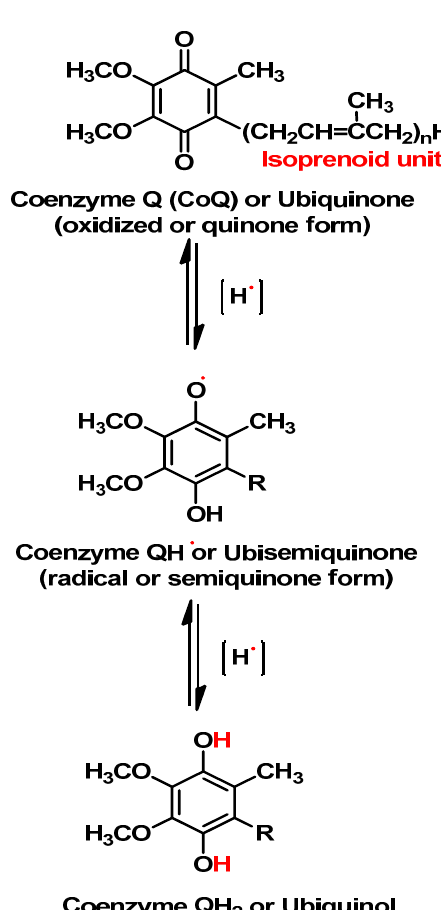
Figure 1. The chemical structure of Coenzyme Q (CoQ) showing the three forms it undergoes during electron transport in oxidative metabolism. The three forms are oxidized form, radical form and reduced form. CoQ (Q) + 2H + + 2e − → CoQH2 (QH2), Eo' = + 0.060